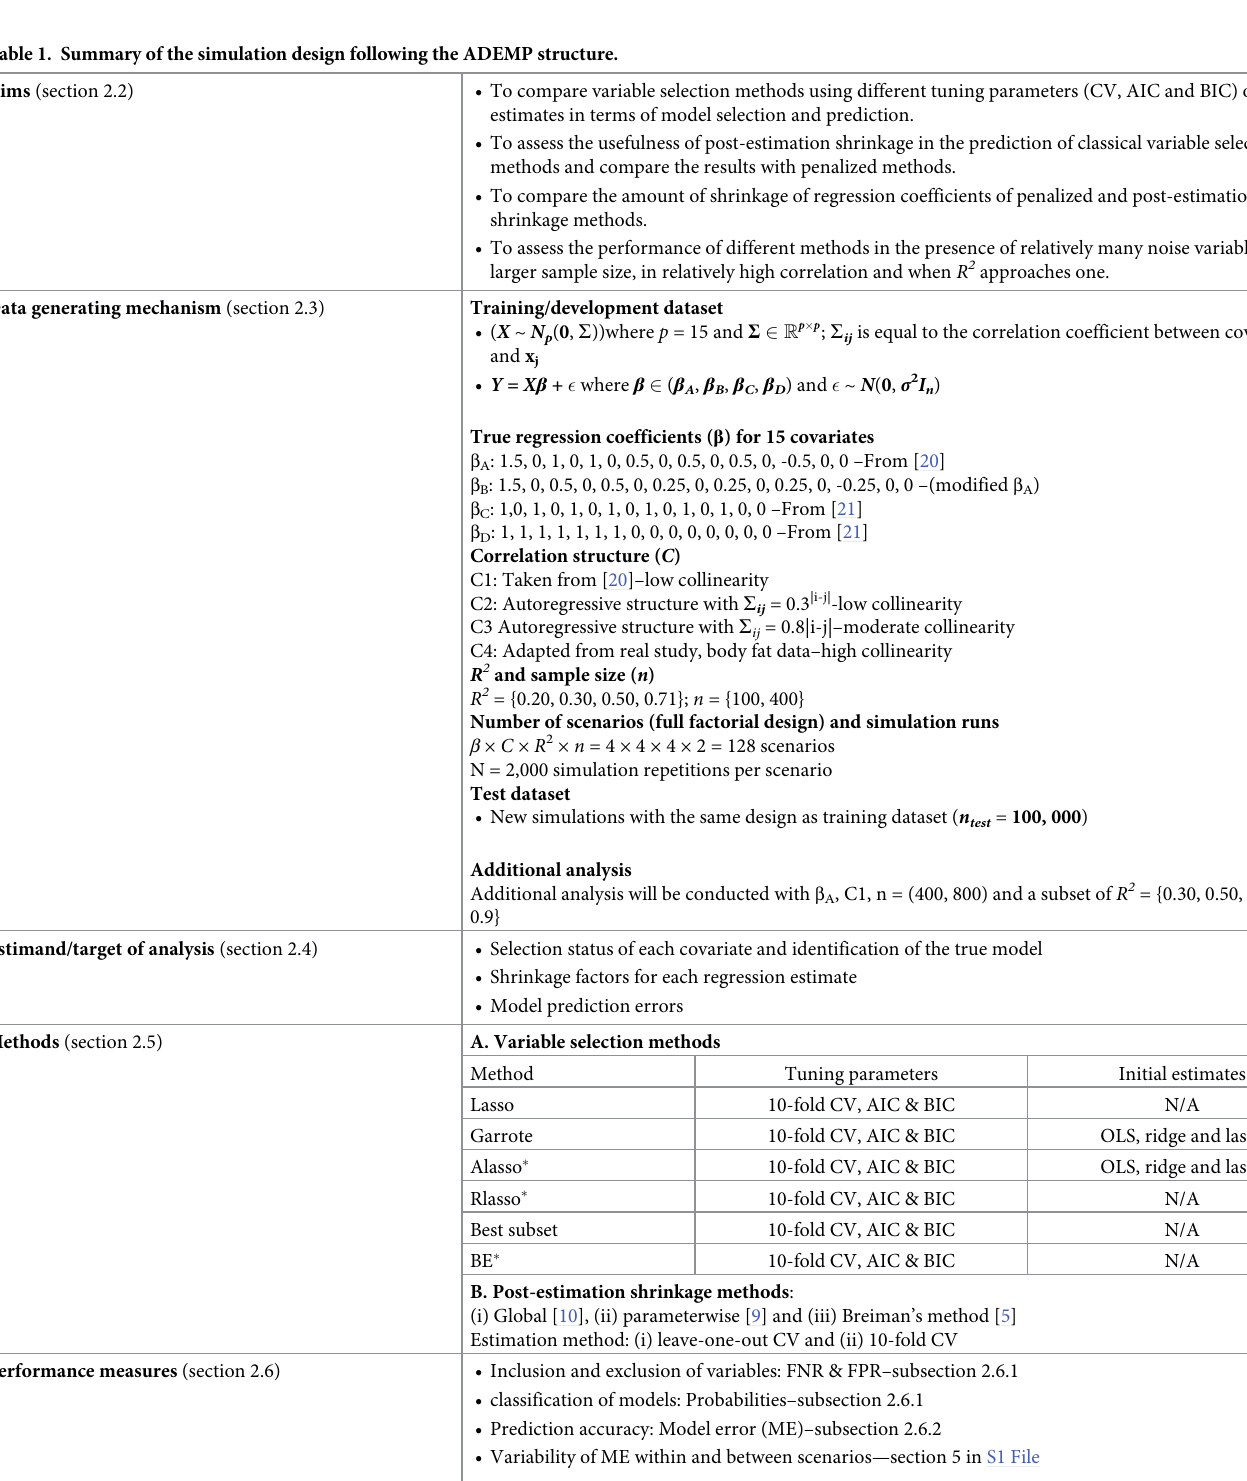
Table 1. Summary of the simulation design following the ADEMP structure. Aims (section